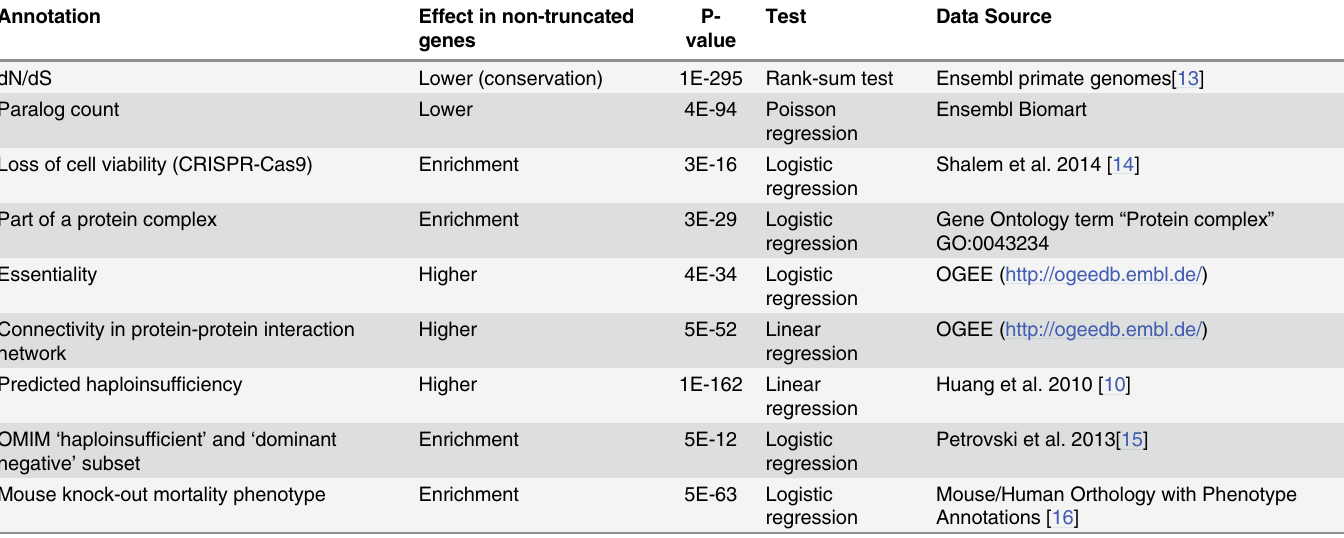
Table 1. Characteristics of the subset of genes (n = 4,204) observed without PTVs after sequencing 16,260 protein coding autosomal genes in 11,546 individuals. Tests compare genes with and without heterozygous